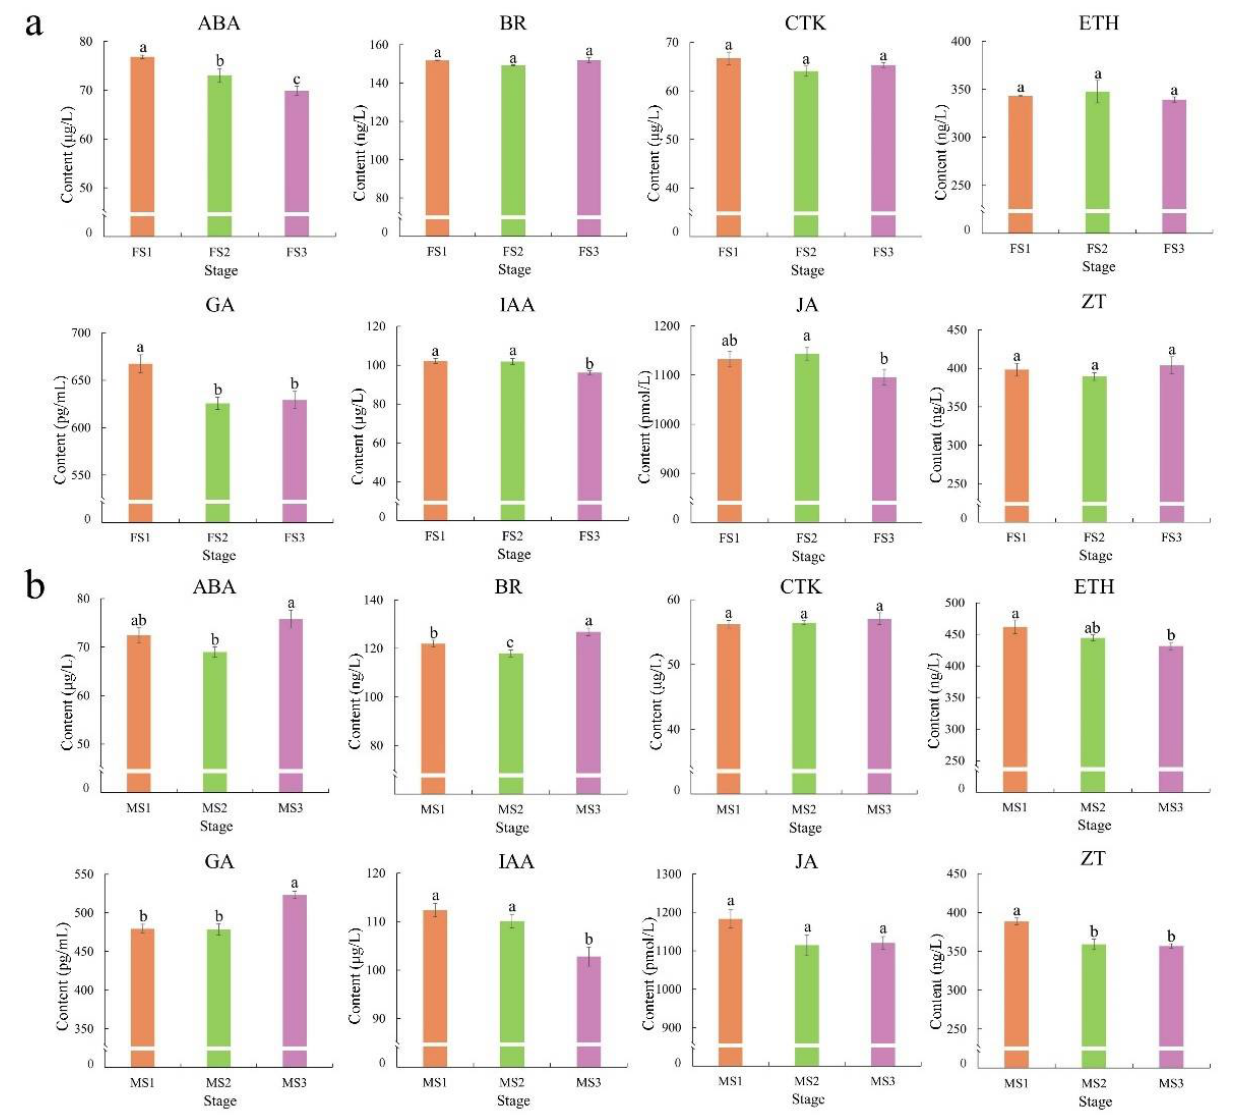
Figure 2. The phytohormones content during the flowering transition process. ( a ) female flower; ( b ) male flower. The x -axis represents the developmental stages of female and male, and the y -axis indicates the phytohormones content obtained by ELISA and HPLC. The differences analysis was performed using the IBM SPSS Statistics v25.0 software with the Student–Newman–Keuls multiple range test; Error bars represent the SD of the means at n = 3; Bars with different lowercase letters are significantly different ( p < 0.05).